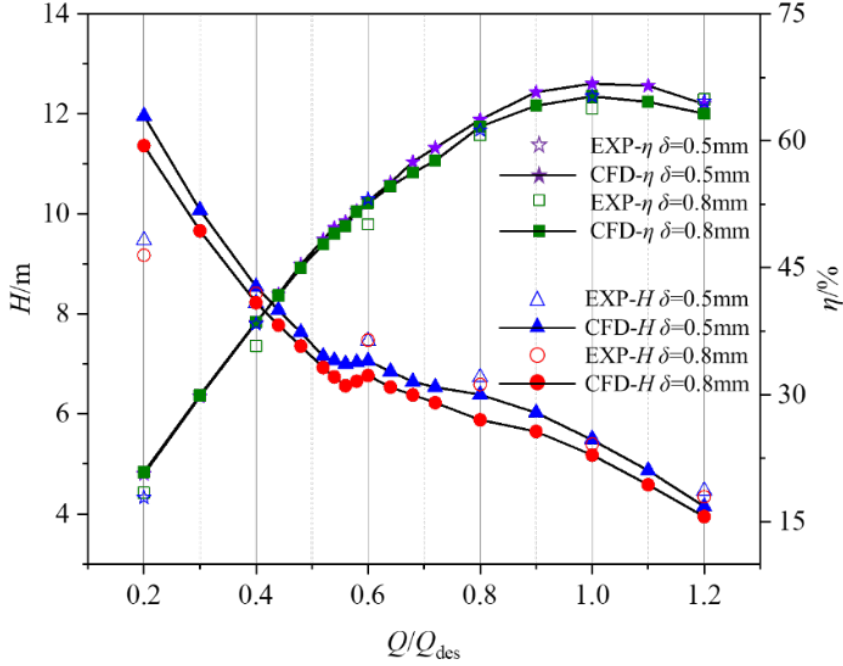
Figure 4. Comparison of external characteristics between CFD and experiment.